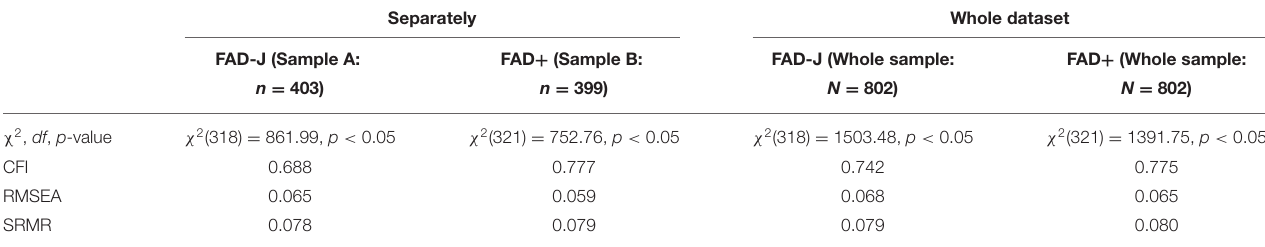
TABLE 2 | The fit indices of multigroup confirmatory factor analysis of FAD + and FAD-J. χ 2 , df , p -value CFI RMSEA SRMR AIC 1 CFI (vs. Configural Configural invariance χ 2 (636) = 1614.74, p < 0.05 Scalar invariance Structural invariance χ 2 (665) = 1698.21, p <